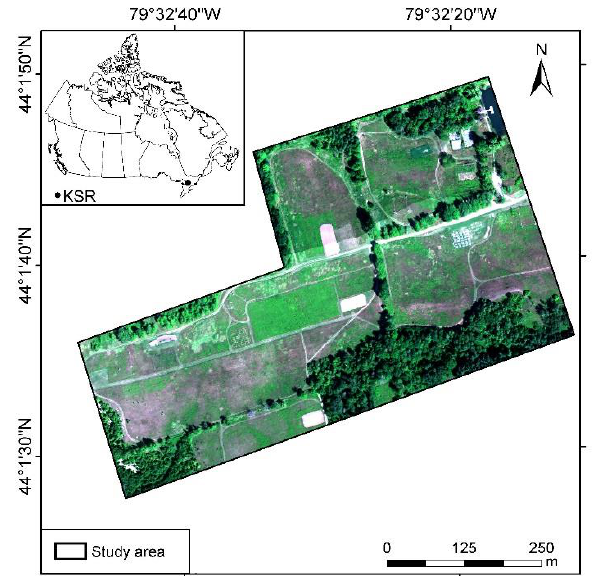
Figure 1. Study area. (Background is a hyperspectral image acquired on 26 August 2016 with bands 660, 550, and 480 nm color composition.).